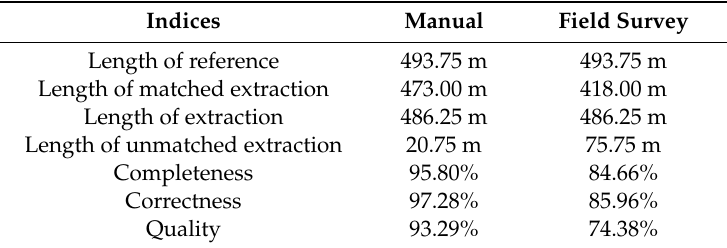
Table 4. Completeness and correctness